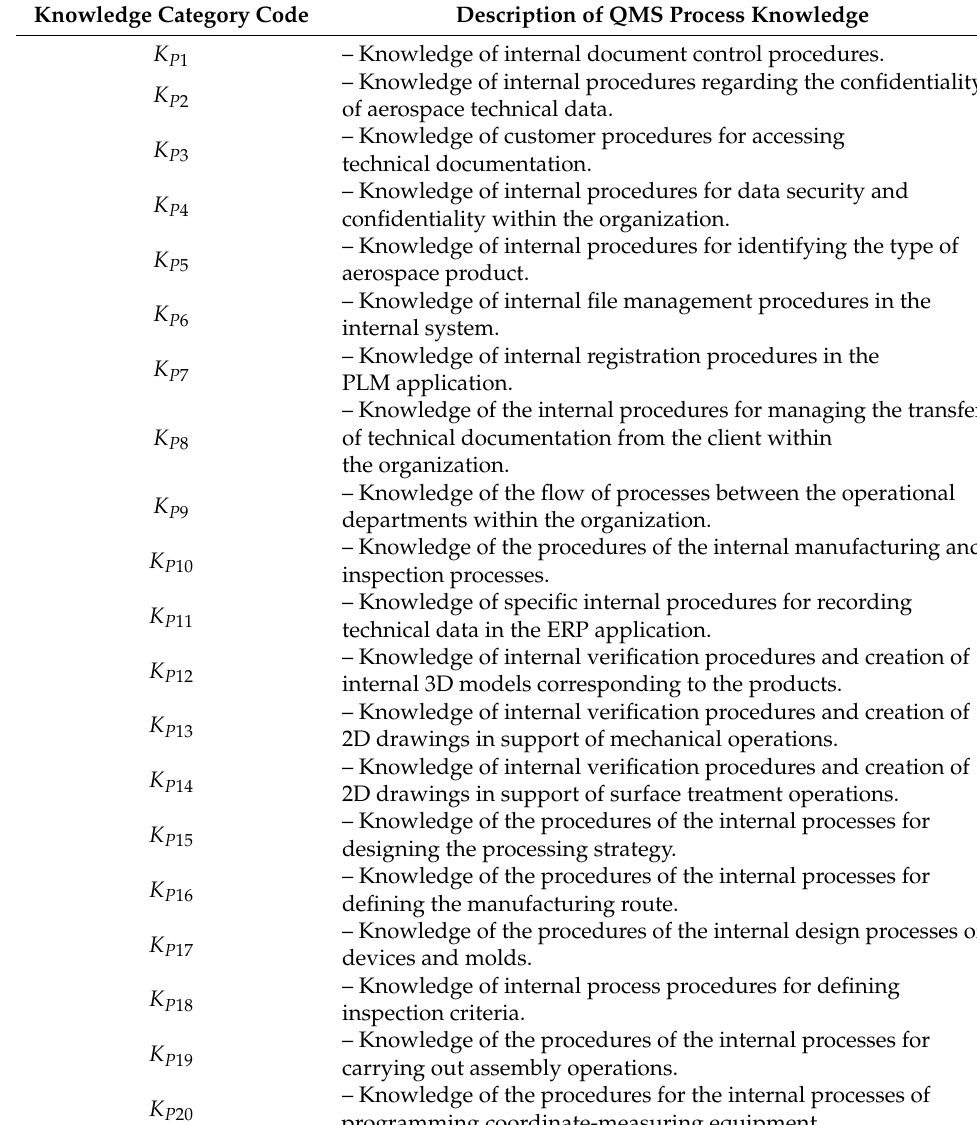
Table 9. List of QMS process